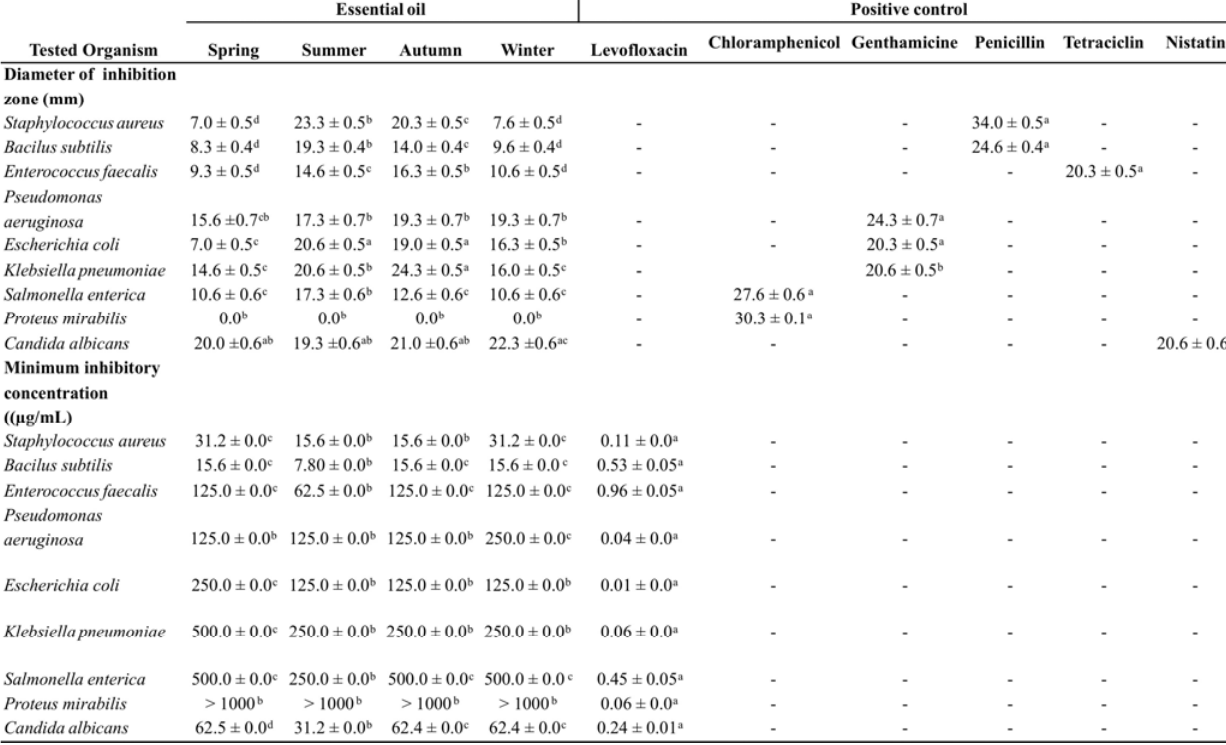
Table 2. Season variation in antimicrobial activity of Tetradenia riparia essential